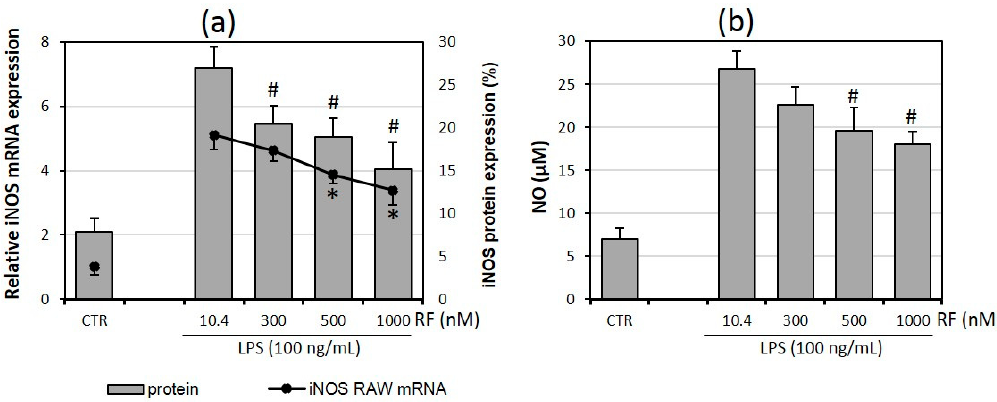
Figure 5. Effects of various riboflavin concentrations (10.4; 300; 500; 1000 nM) on LPS-induced nitric oxide synthase (iNOS) mRNA and protein expression ( a ) and nitric oxide release (NO; b ) by RAW 264.7 macrophages cultured in adipocyte-macrophage co-cultures. Fully differentiated adipocytes 3T3 L1 and macrophages RAW 264.7 were cultured in 12-well dishes with inserts (0.4 µ m pore size) for 6 h (mRNA, protein expression) or 24 h (NO release) after LPS stimulation (100 ng/mL). CTR – control group (* p < 0.05 significance compared with 10.4 group for iNOS mRNA expression; # p < 0.05 significance compared with 10.4 group for iNOS protein expression and NO release to supernatant). Statistical